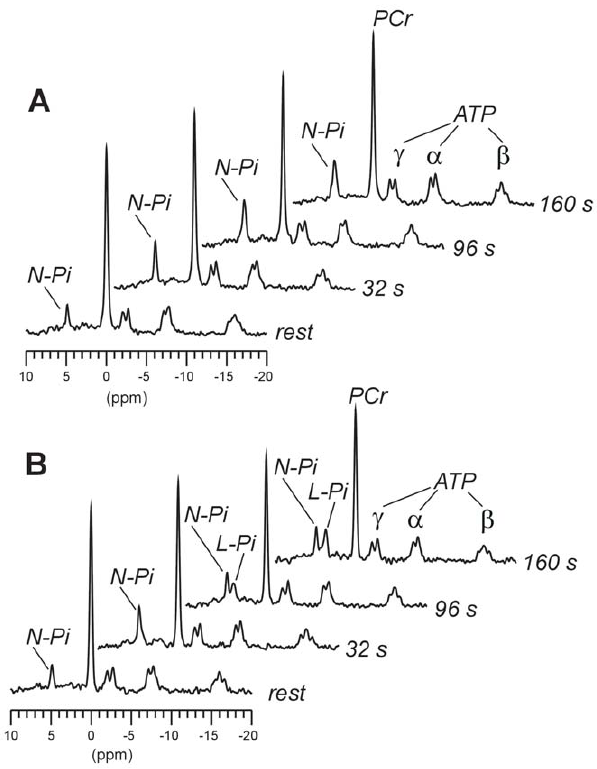
Figure 1. Representative 31 P spectra of the finger extensor muscles at rest and during exercise. A, MRS pattern A (control); B, MRS pattern B (patient). Peak assignments: ATP, adenosine triphos- phate; PCr, phosphocreatine; Pi, inorganic phosphate (N-Pi, neutral-pH peak; L-Pi, low-pH peak). The spectra are the sum of 32 scans (64 s) The displayed spectra times are the centre points of such time periods. Note the appearance of a second and acidic Pi peak (L-Pi) in pattern B spectra. Exercise in the chosen example of pattern A was performed for a longer time period without Pi splitting, but only the same time points as in pattern B example are shown for comparison